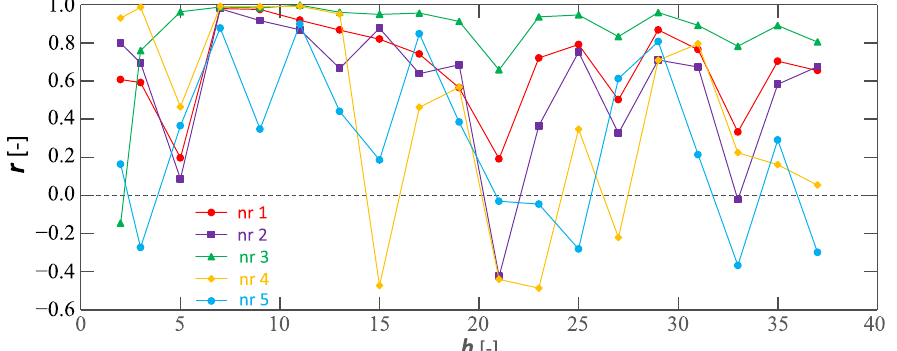
Figure 40. Correlation r coefficient of characteristics of h -th harmonics of the voltage and current for considered charging processes, which are defined as Cases